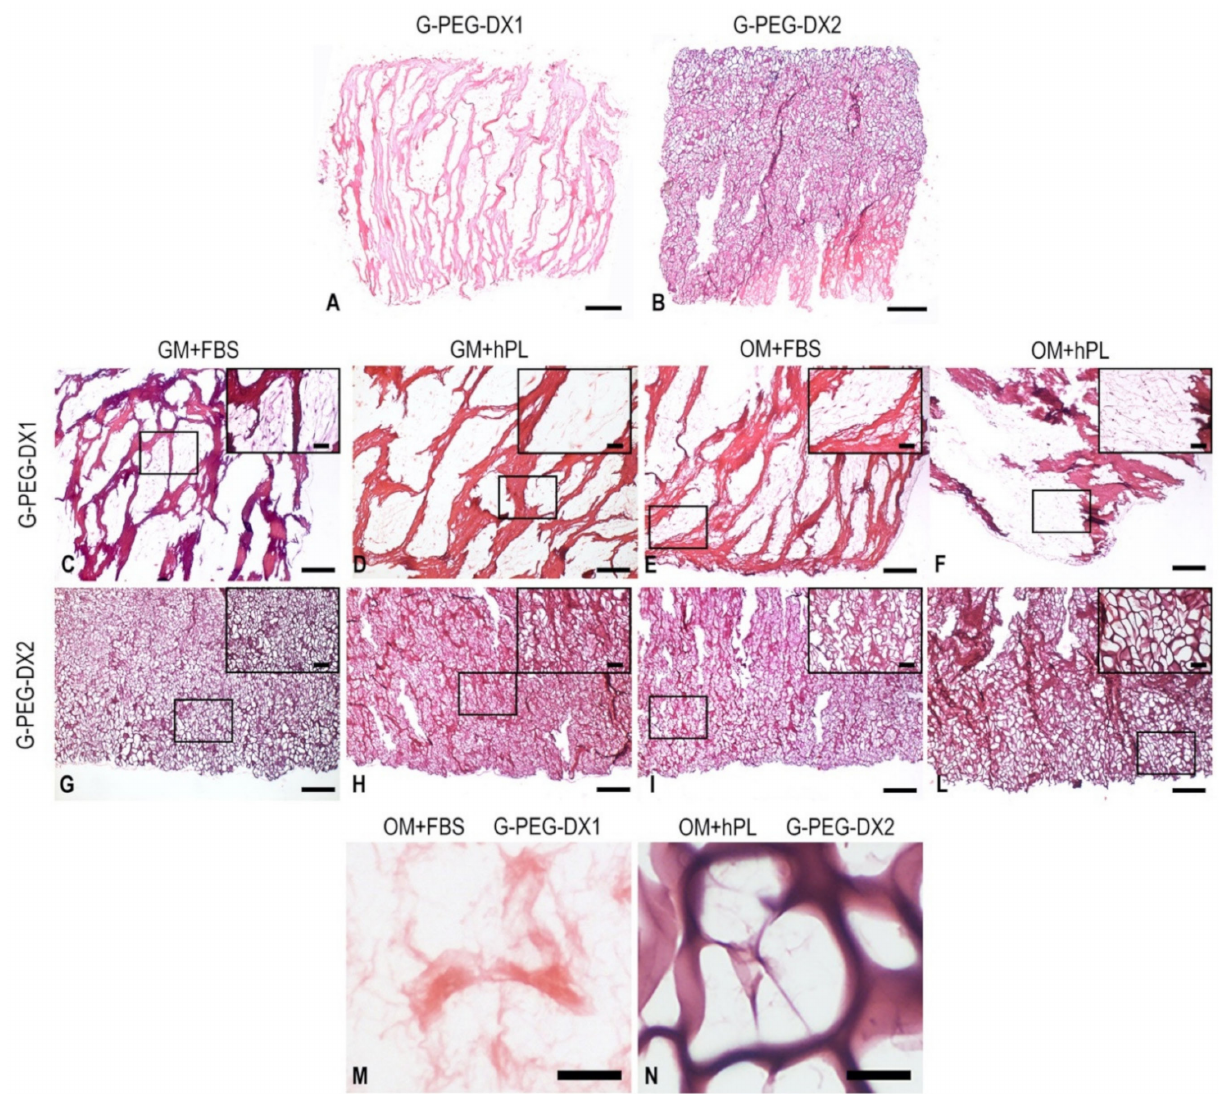
Figure 2. Microphotographs of H&E stain for morphology of hydrogels, cell colonization and extracellular matrix deposition. Microphotographs of G-PEG-Dx1 ( A , C – F , M ) and G-PEG-Dx2 ( B , G – I , L , N ) under the different culture conditions: GM+FBS ( C , G ), GM+hPL ( D , H ), OM+FBS ( E , I , M ), OM+hPL ( F , L , N ). Microphotographs of G-PEG-Dx1 (control A ) and G-PEG-Dx2 (control B ) without cells and treatment. Scale bar: 500 µ m for ( A , B ); 200 µ m—inset 50 µ m for ( C – L ); 10 µ m for ( M , N